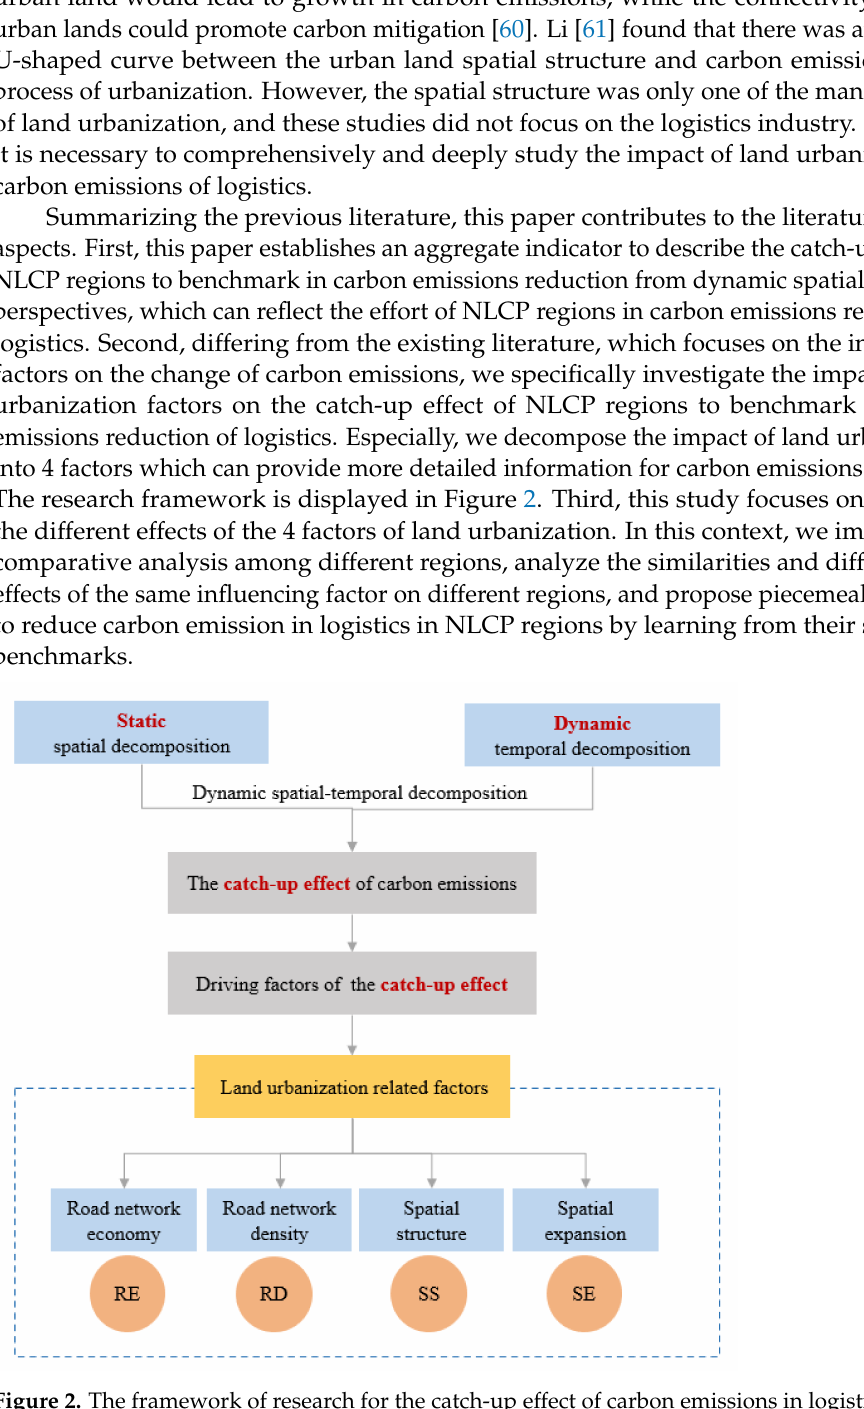
Figure 2. The framework of research for the catch-up effect of carbon emissions in